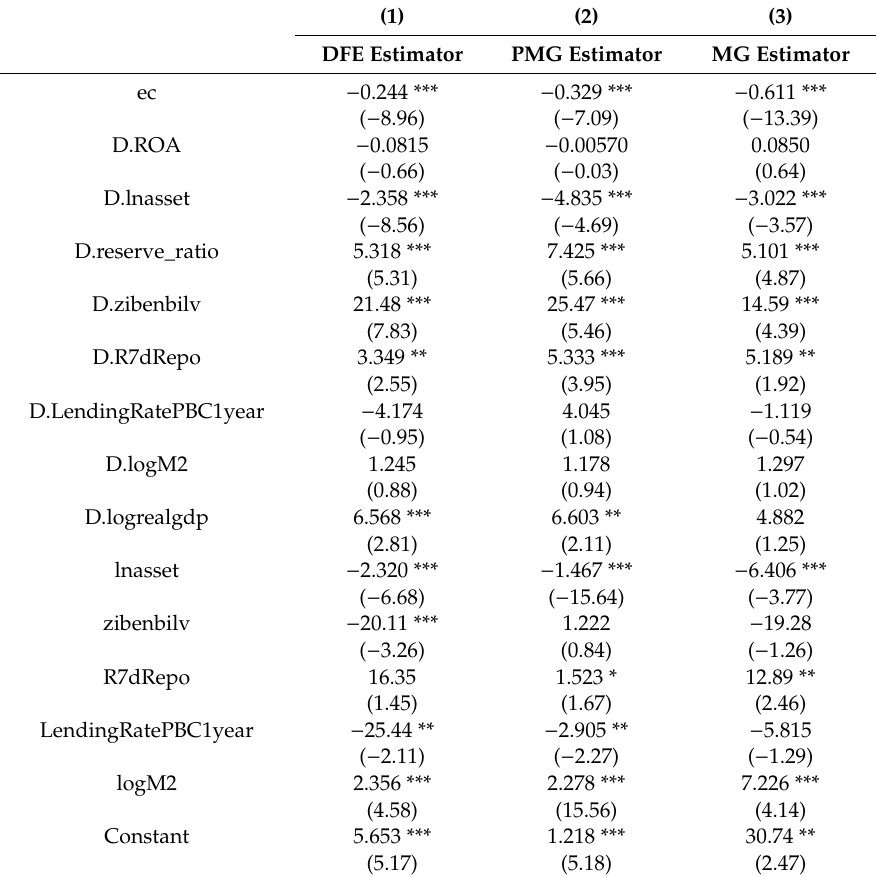
Table 6. Results of the regression analysis of Model